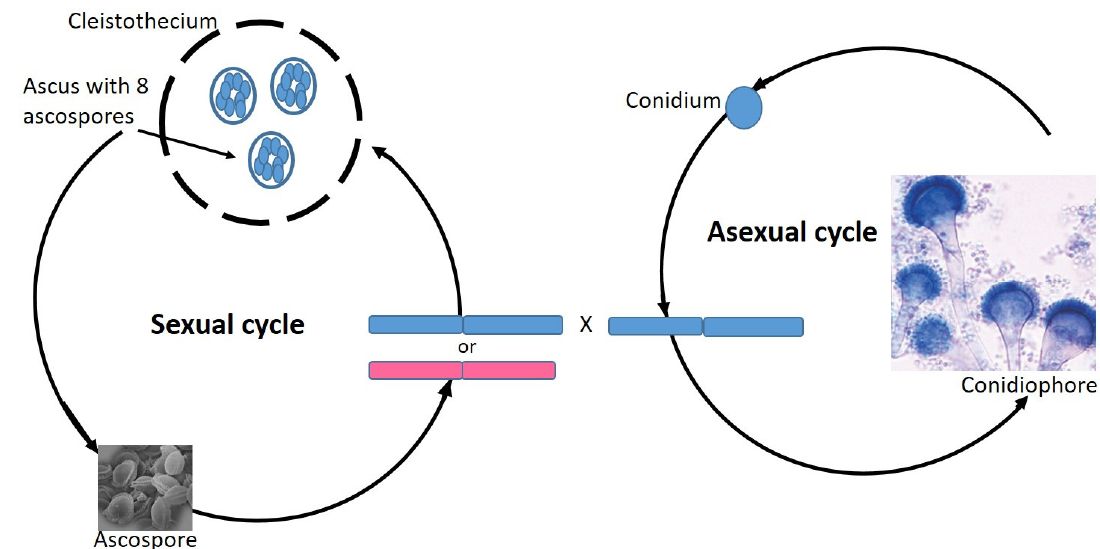
Figure 4. Reproduction in Aspergillus fumigatus . Asexual reproduction in A. fumigatus is via mitotic division of haploid (1N) cells or through the formation of asexual conidiospores. Sexual reproduction is heterothallic between MAT1-1 and MAT1-2 mating types. The mating product are cleistrothecia containing multiple ascospores.